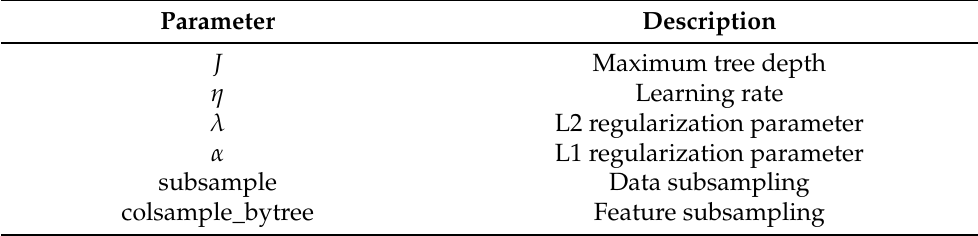
Table 1. Selected XGBoost